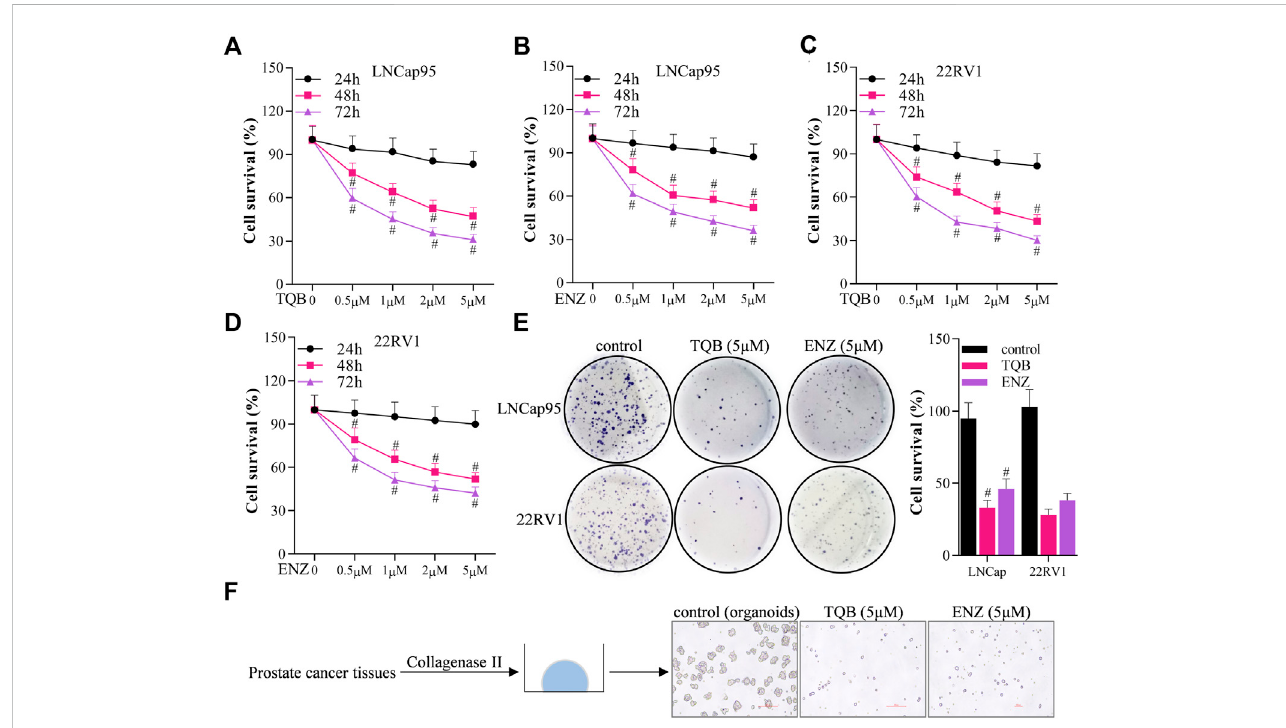
FIGURE 1 TQB3720 inhibited the growth of prostate cells (A – D) Sulforhodamine B assays were conducted to detect the effect of TQB3720 on the proliferation of LNCap95 and 22RV1 cells, # p < 0.01 vs. 24 h. (E) Effect of TQB3720 on colony formation of LNCap95, 22RV1 cells, # p < 0.01 vs. 24 h. (F) Organoid assay showing the effect of TQB3720 on organoid formation of clinic human prostate cancer primary